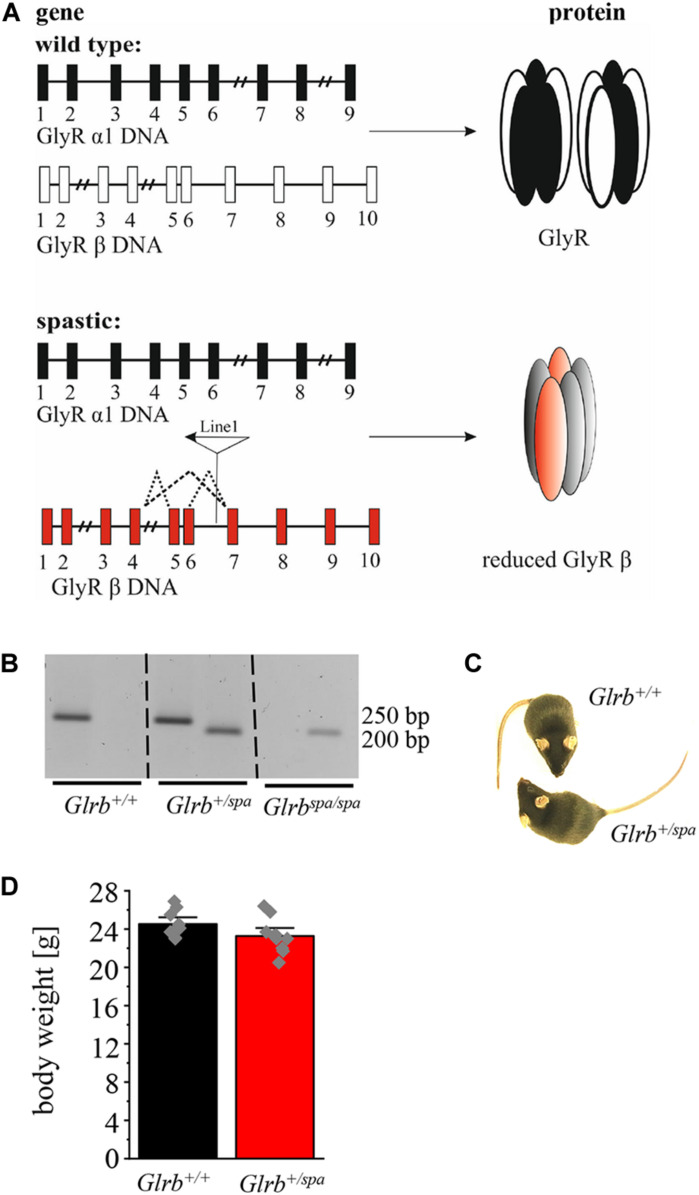
A LINE-1 insertion into the Glrb gene underlies the mouse mutant spastic. (A) Schematic overview of Glra1 (9 exons) and Glrb (10 exons) genes and protein level. Upper part shows the wild type situation (black and white), lower part depicts the situation in spastic mice (black and red). Left column depicts changes at DNA levels, see insertion of LINE-1 element in Glrb generating spastic mice (red exons) leading to different splice variants indicated by dotted lines. Right column: protein level of GlyRs. Note that the amount of the full length GlyR β is reduced in spastic mice. (B) Representative image of genotyped mice (Glrb+/+, Glrb+/spa, and Glrbspa/spa mice). Wild type (wt) animals show a single 250 bp band, heterozygous animals show two bands (250 and 200 bp), homozygous spastic mice display a band of 200 bp. (C) Images of wt Glrb+/+ and heterozygous spastic Glrb+/spa animals with no obvious changes in size, and appearance of the coat. (D) Comparison of the body weight of Glrb+/spa mice (n = 10, red bar) and Glrb+/+ mice (n = 9, black bar) investigated in this study. Body weight data show mean values ± standard error of the mean (S.E.M). Single data points are shown as gray color squares.